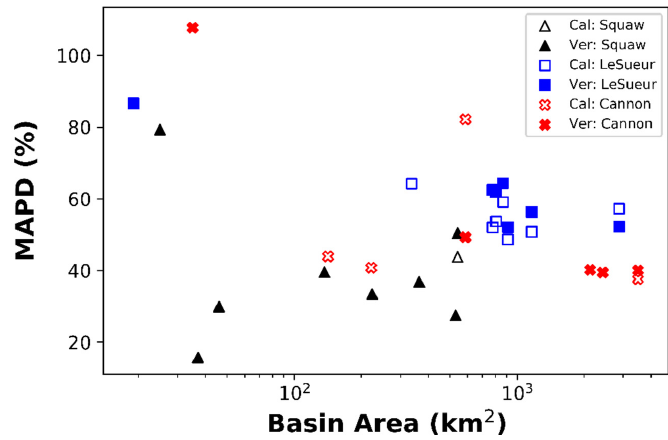
Figure 3. Mean absolute percent deviation (MAPD) versus basin area (plotted on a log scale) for all watersheds and subwatersheds for the calibration (Cal) and verification (Ver) periods for simulated discharge produced from NLDAS-2 inputs.